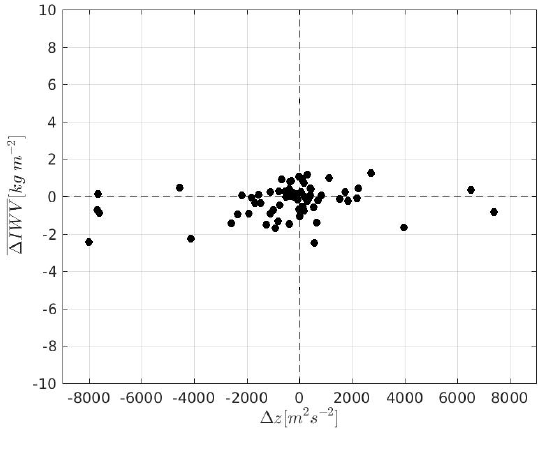
Figure 4. Values of (cid:49) IWV ( (cid:49) IWV = IWV GNSS − IWV ERA-Interim ) as a function of (cid:49)z after applying the pro- posed